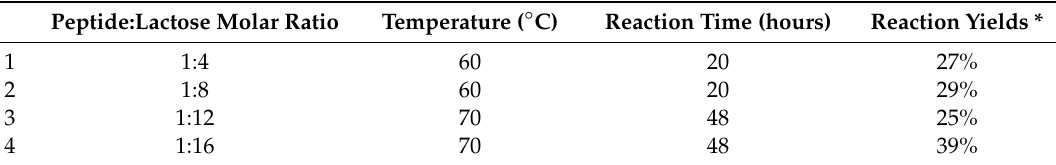
Table 6. Reaction conditions tested for peptide lactosylation.